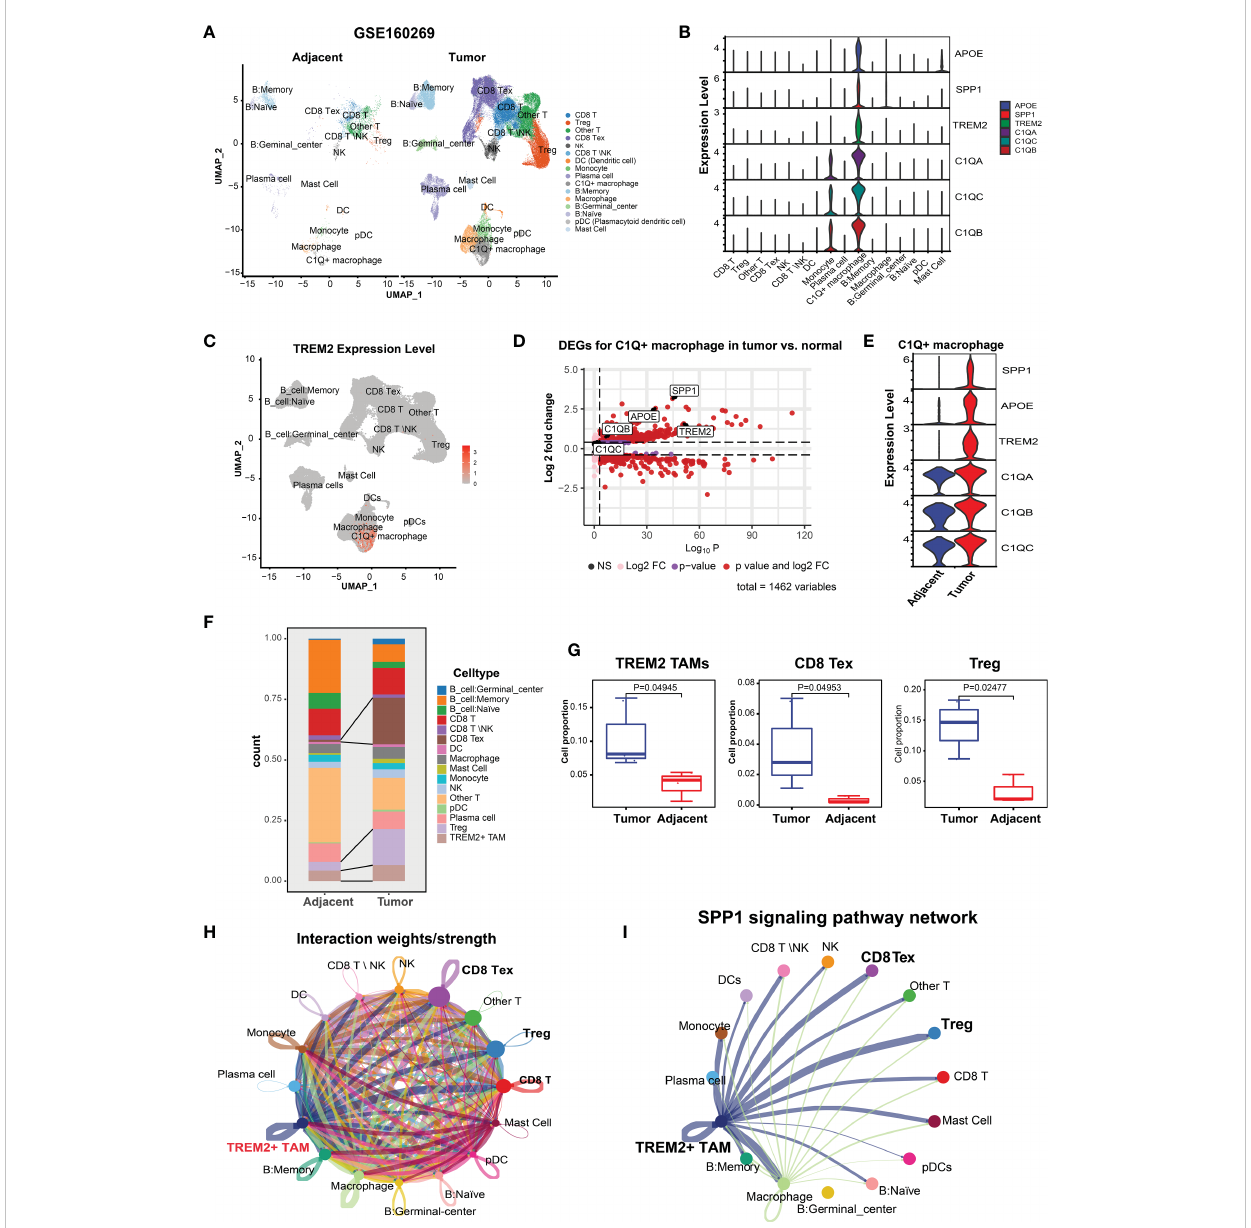
FIGURE 1 Identi fi cation and characterization of TREM2 + TAMs in ESCC by scRNA-seq analysis (GSE160269). (A) UMAP plot of cells colored by cell types and splitted by tumor and adjacent normal tissue. (B) Violin plot showing expression level of APOE , SPP1 , TREM2 , C1QA , C1QC , and C1QB among 16 cell types. (C) UMAP plot showing expression level of TREM2 in each cell type. (D) Volcano plot showing differentially expressed genes of C1Q + macrophage in tumor vs. adjacent normal tissue. (E) Violin plot showing expression level of SPP1 , APOE , TREM2 , and three complement genes in C1Q + macrophage between tumor and adjacent normal tissue. (F) Cell proportion of each cell type in tumor and adjacent norm tissue. (G) Cell proportion comparison of TREM2 + TAMs, CD8 Tex and Treg between two group, each dot represents a sample. (H) Cell-cell interaction network generated by CellChat. (I) Cell-cell communication network via SPP1 signaling